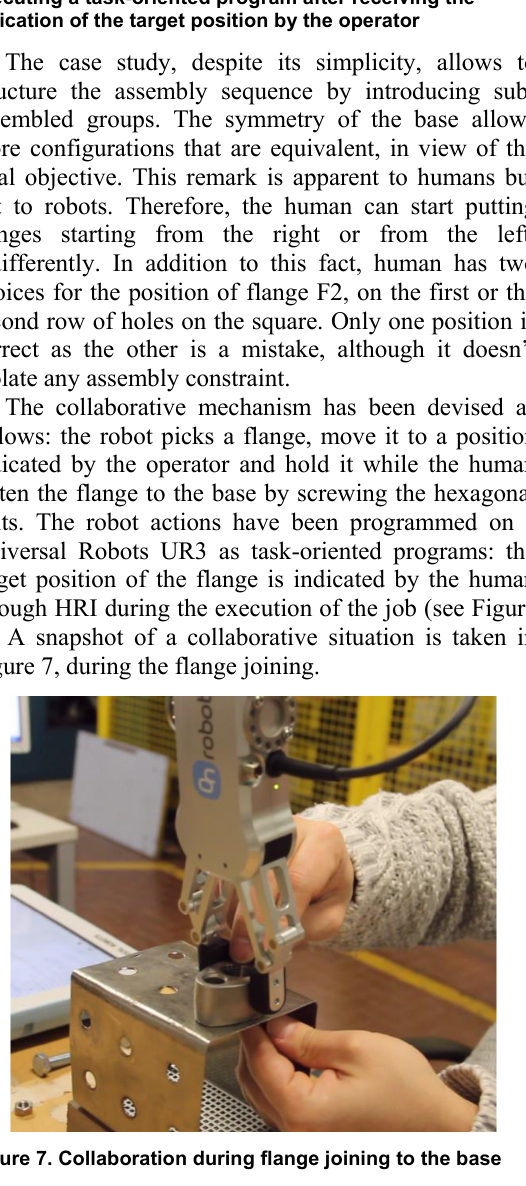
Figure 6. Robot mounts the square flange on the base by executing a task-oriented program after receiving the